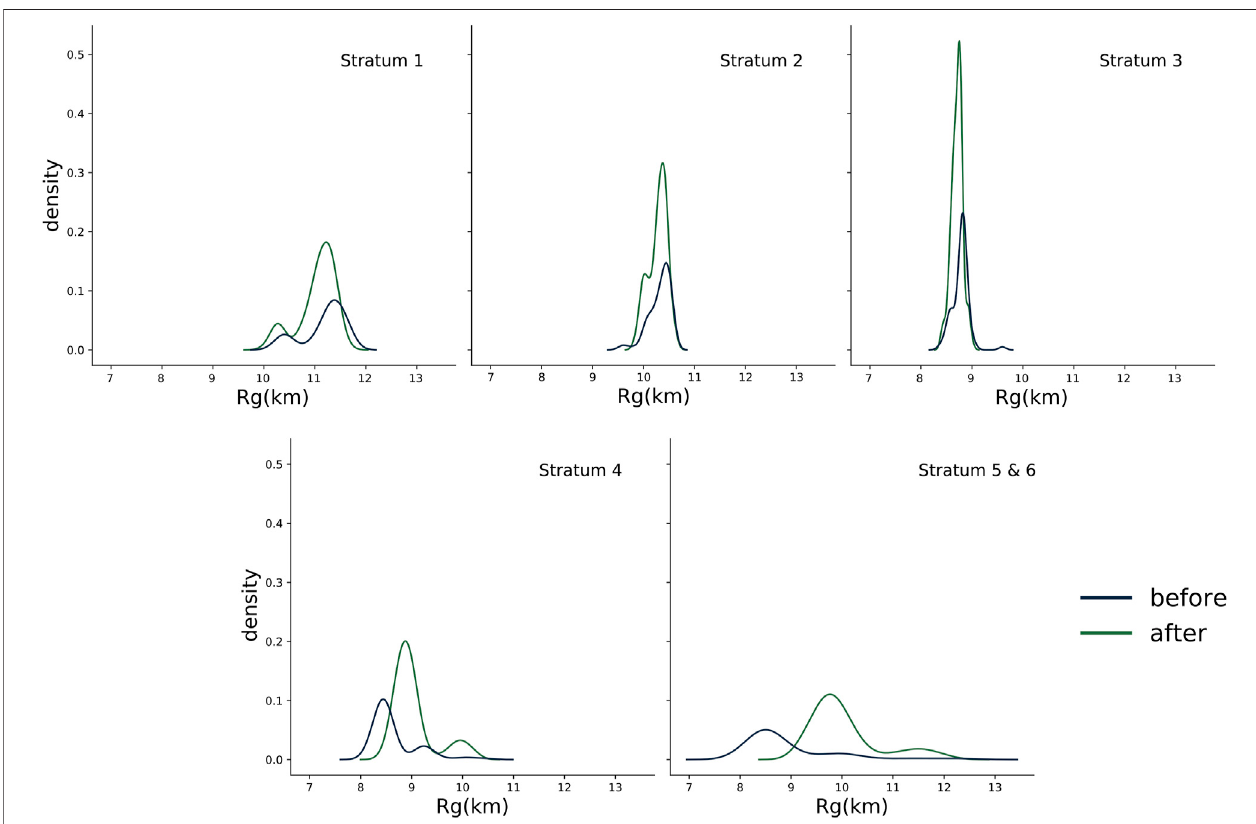
FIGURE 8 | Distributions of Average Radius of Gyration (Rg) in km. Blue is the distribution before the lockdown. Green is the distribution after the fi rst economy re- opening.